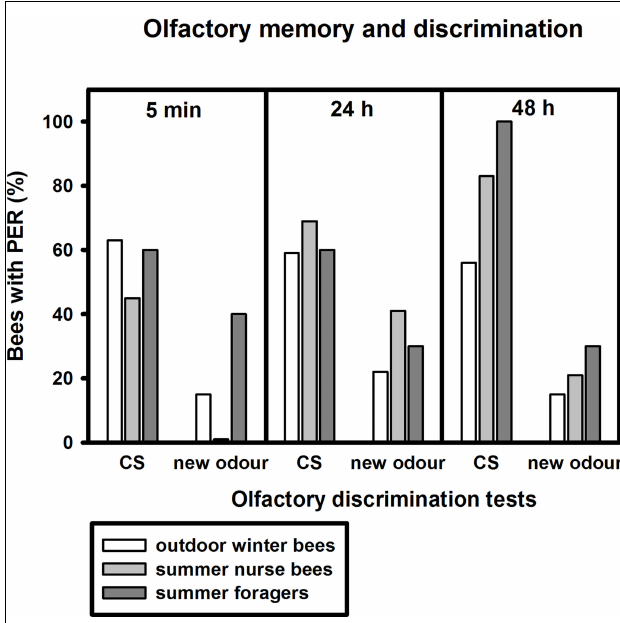
FIGURE 2 | Olfactory memory and discrimination of outdoor winter bees, summer nurse bees and summer foragers. The x -axis displays the tested stimuli (conditioned odour carnation (CS) or new odour cineole) at 5 min, 24 h or 48 h after conditioning. The y -axis shows the percentage of bees displaying the proboscis extension response (PER). For statistics see text. The same individuals as in Figure 1 are displayed minus individuals that did not survive the 48-h